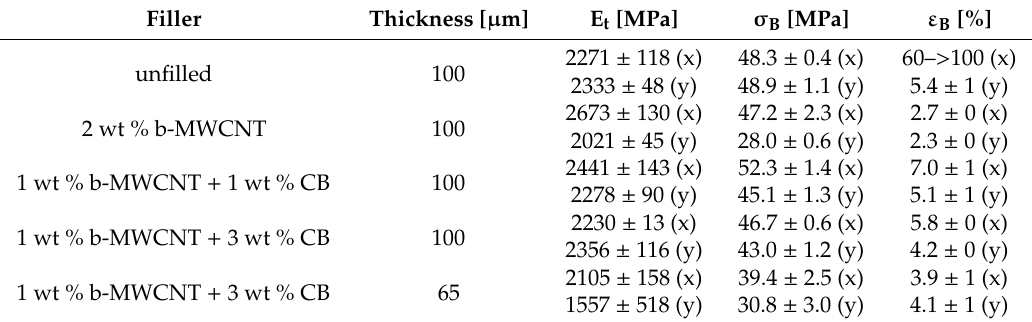
Table 3. Tensile test results of extruded films based on PVDF1 composites. Filler Thickness [ µ m] E t [MPa] σ B [MPa] ε B [%] 2271 ± 118 unfilled 100